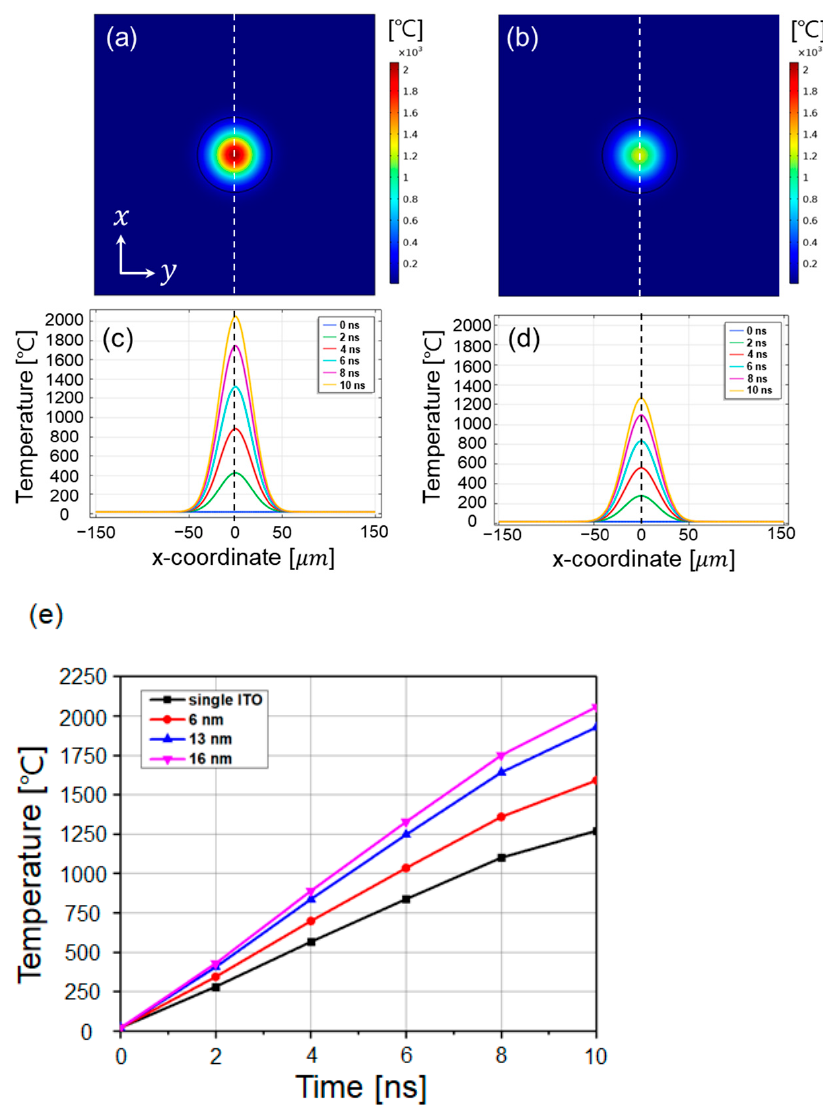
Figure 10. Transient temperature analysis in XY-plane (z = 0). Temperature distributions of ITO (53 nm)/Ag (16 nm)/ITO (53 nm) on 1 µ m thick glass substrate ( a , c ) and of ITO SL on the same glass substrate ( b , d ). Transient temperature variations for every 2 ns presented by different color lines. ( e ) Comparison of temperature variations on central point, (x, y, z) = (0, 0, 0) during entire pulse duration (0 to 10 ns) based on variation of silver layer thickness (6, 13, and 16 nm).